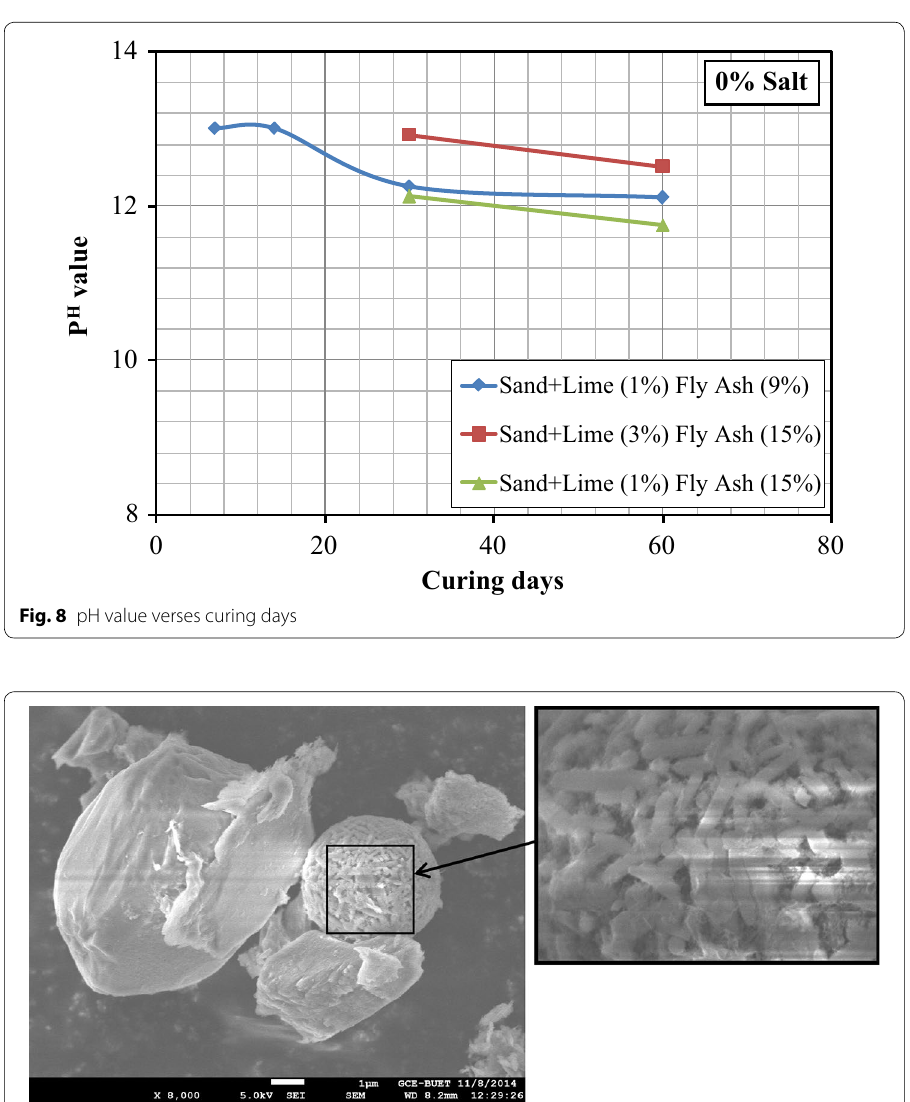
Fig. 9 Scanning electron microscopic view of lime and fly ash after